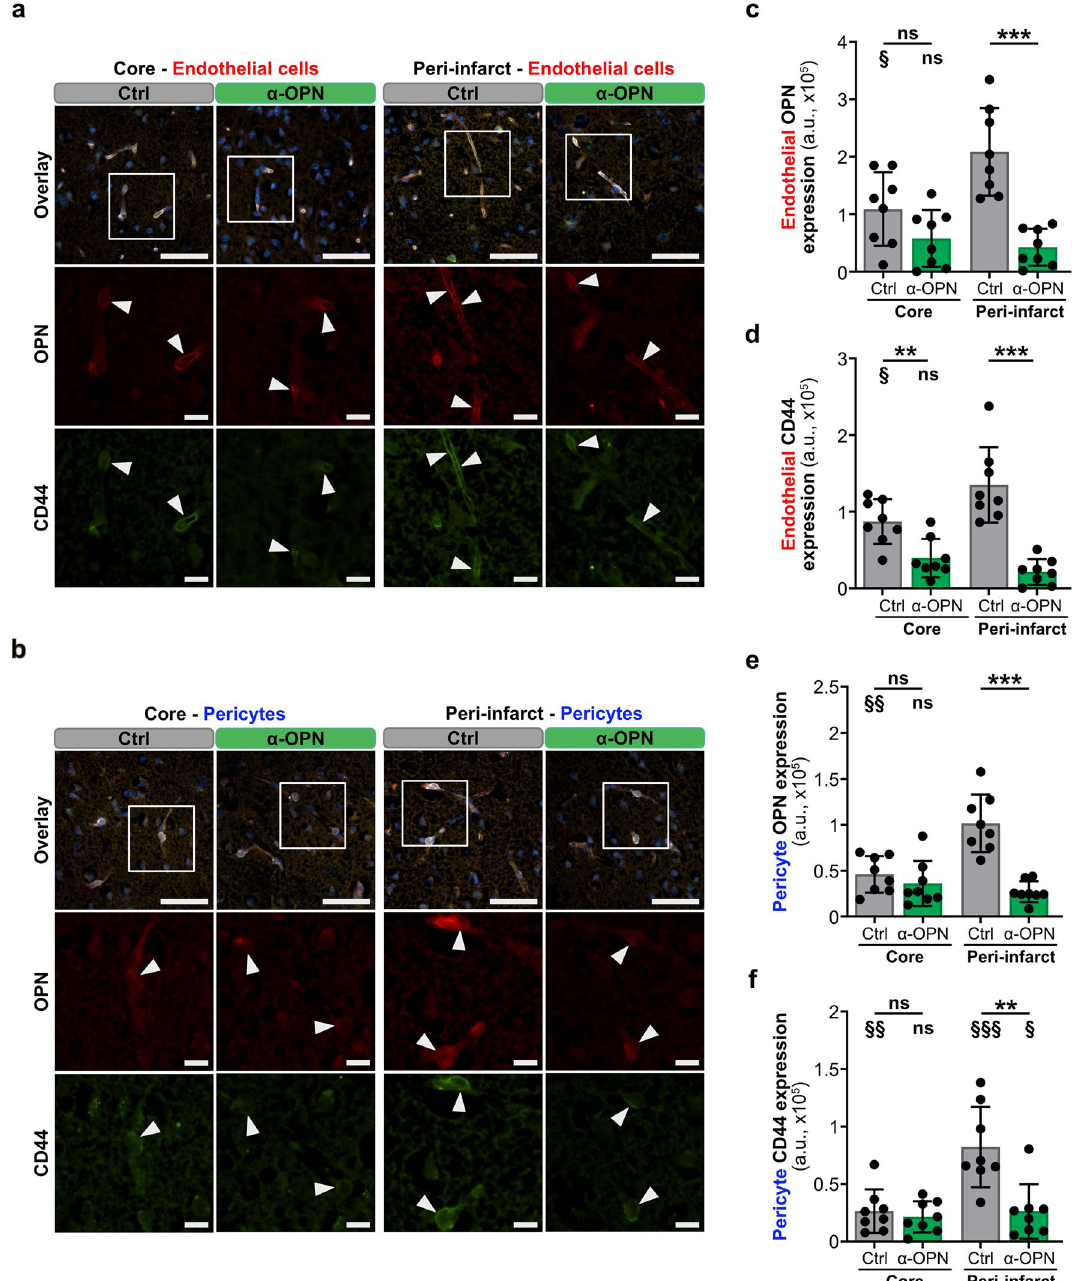
Figure 3. Anti-osteopontin antibody treatment reduces osteopontin and CD44 receptor expression in microvascular endothelial cells and pericytes after acute ischemic stroke. ( a , b ) Representative images of immunofluorescence staining for osteopontin (OPN, red, inset), CD44 receptor (green, inset) and cell-specific markers (white, overlay) including podocalyxin for endothelial cells ( a ) and CD13 for pericytes ( b ) in the infarct core and peri-infarct region of Ctrl IgG and α-OPN antibody-treated mice 24 h post-ischemic stroke. White arrowheads indicate osteopontin and CD44 receptor expressing endothelial cells and pericytes. ( c–f ) Quantification of osteopontin and CD44 receptor expression intensity (arbitrary unit, a.u.) in endothelial cells ( c , d ) and pericytes ( e , f ) in the infarct core and peri-infarct region utilizing 3 images/region/animal, n = 8 and 8 for Ctrl IgG and α-OPN antibody treatment group, respectively; § P < 0.05, **/ §§ P < 0.01, ***P < 0.001 and not significant (ns) P > 0.05. *Indicates two-tailed, unpaired t-test with Welch’s correction when variances were significantly different based on F-test, comparing the two treatments groups for the same region, and § indicates two-tailed, paired t-test comparison of infarct core to peri-infarct region within the same treatment group. Scale bars 50 µm and 10 µm in insets ( a , b